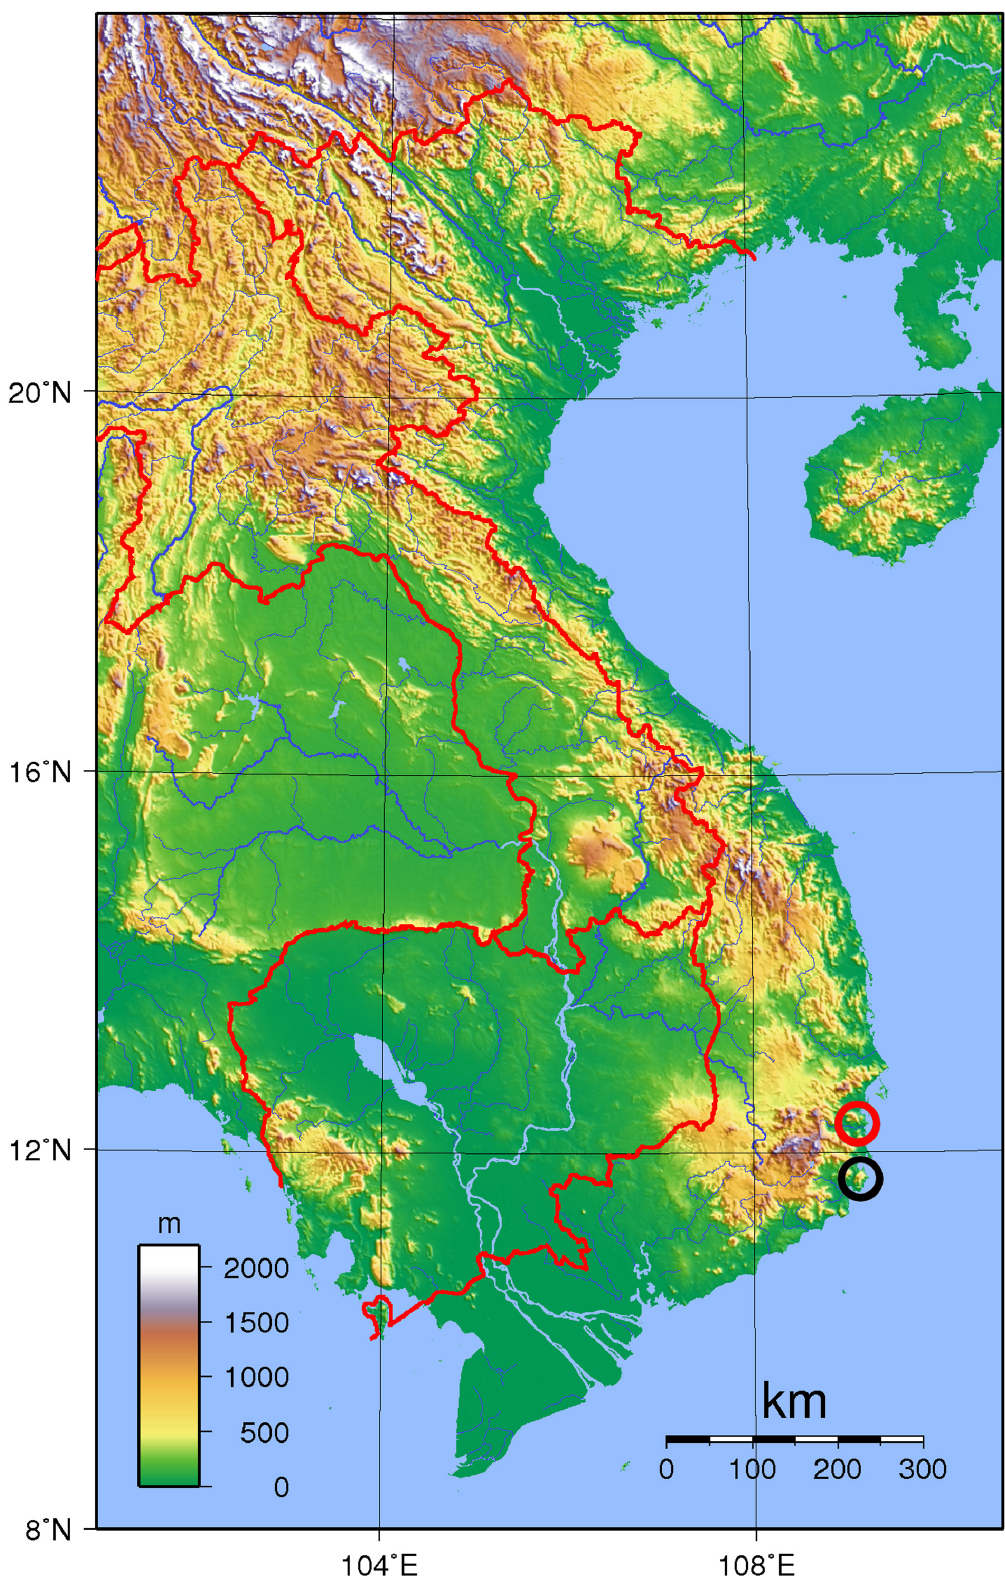
Fig. 6. Distribution map of Phasmomantella nuichuana gen. et sp. nov. (black circle) and Phasmomantella pallida (Roy, 2001) (red